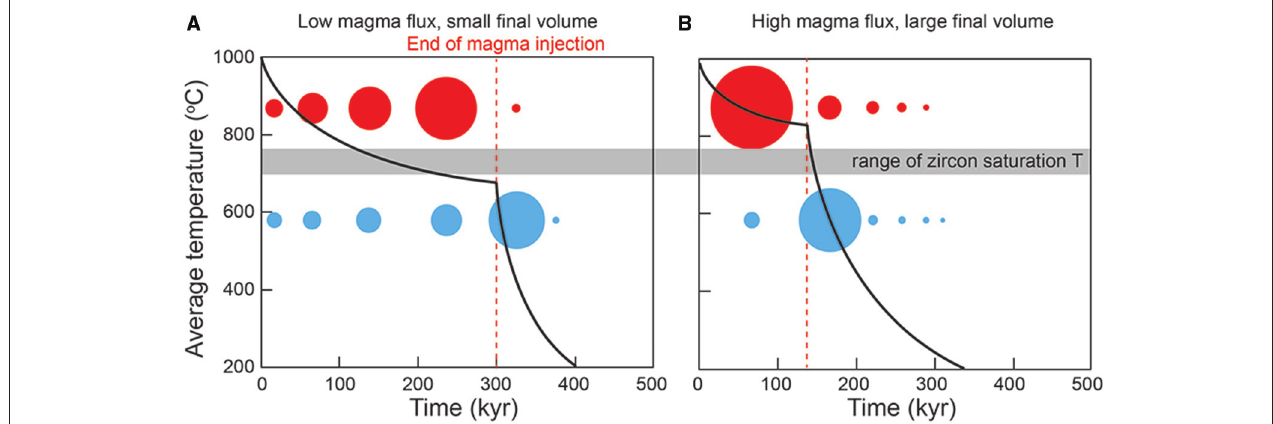
FIGURE 3 | Schematic representation of the evolution of the relative volume of magma above (red circles) and below (light blue circles) the range of zircon saturation temperature in time. (A) Temporal evolution of volumes and temperature for a magmatic reservoir of small volume assembled at low average magma flux. (B) Temporal evolution of volumes and temperature for a magmatic reservoir of large volume assembled at high average magma flux. The black line shows the evolution in time of the average temperature of the intrusion.